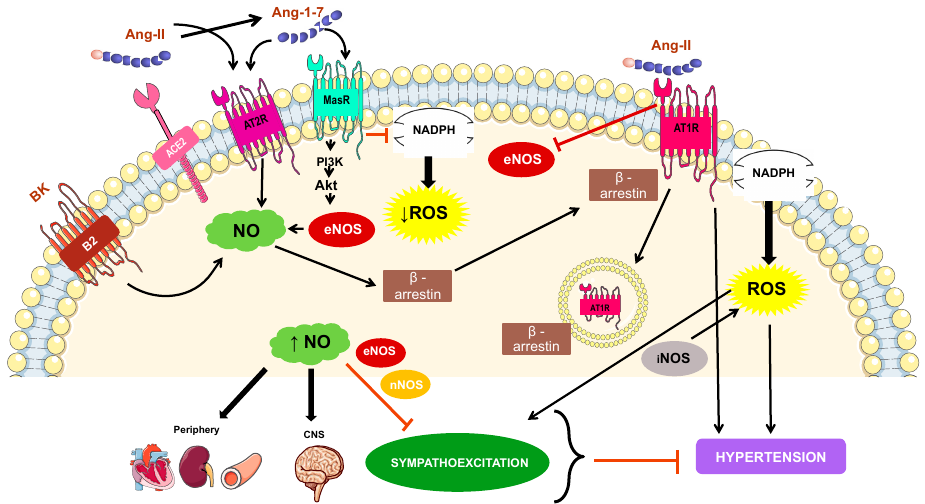
Figure 2. Mechanisms involved in NO-related hypertension. The effects of angiotensin II (Ang-II) are mediated by its binding to angiotensin type 1 (AT 1 R) and type 2 (AT 2 R) receptors. AT 1 R is responsible for the classic pro-hypertensive activity of Ang-II, including NADPH oxidase activation and reactive oxygen species (ROS) production. Ang-II undergoes the action of angiotensin converting enzyme type 2 (ACE2) into angiotensin 1–7 (Ang-(1–7)), which classically interacts with Mas receptor (MasR) and induces the PI3K/Akt pathway activation and consequent phosphorylation of eNOS. The activation of MasR also downregulates NADPH activity, reducing ROS levels. Furthermore, Ang-(1–7) can also bind to AT2R, which stimulates the bradykinin (BK)–NO cascade. It is important to highlight that, when activated, the BK targets such as the B2 receptors induce NO production. NO, in turn, is responsible for stimulating the β -arrestin pathway that promotes AT1R desensitization and internalization of the receptor. In summary, the increase in NO (from endothelial and neuronal nitric oxide synthase—eNOS and nNOS, respectively) promotes a decrease in oxidative stress, inducing downregulation of sympathoexcitation and consequent inhibition of BP increase in both periphery and different areas of the central nervous system (CNS). Conversely, NO derived from inducible NOS (iNOS) is involved in the rise in sympathetic tonus and ROS production, mechanisms related to triggering hypertension.